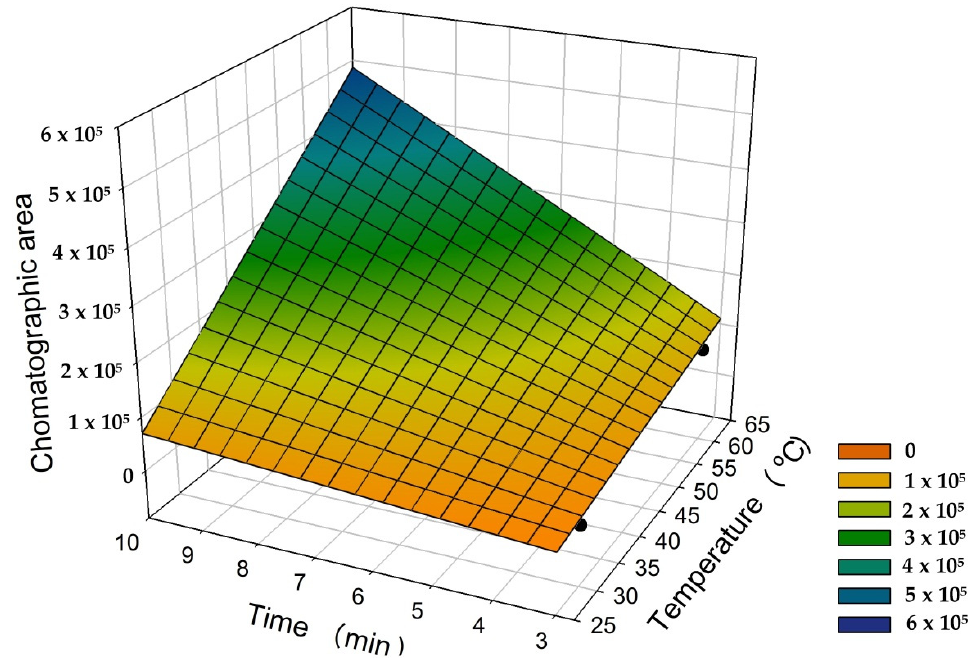
Figure 3. Optimization of safrole extraction from cowpea beans by the headspace solid-phase mi- croextraction method coupled to a gas chromatograph with a flame ionization detector, as a function of temperature and extraction time.